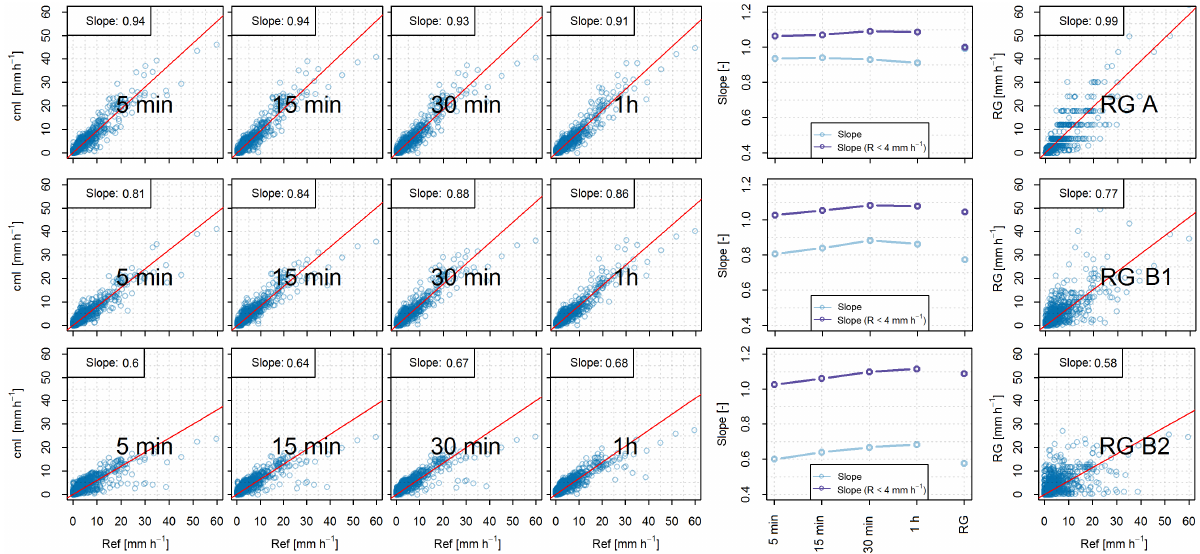
Figure 4. Comparison of mean QPEs from four CMLs to reference rainfall. CMLs are adjusted by rainfall from three different RG layouts (rows) with aggregation intervals of 5, 15, 30min, and 1h (four panels on the left), in addition, rainfall from the RG layouts alone is compared to the reference areal rainfall (right panel). Linear trend-line intersects are set to zero. The middle panel plots the relationship between the slope of the trend lines and aggregation times as well as the slope of the RG layouts.